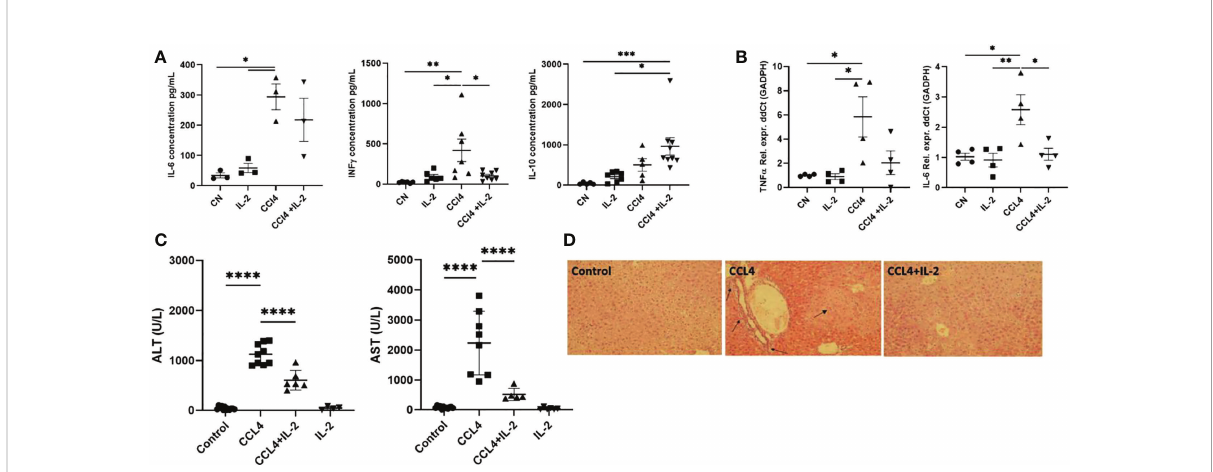
FIGURE 6 Impact of IL-2 administration on the modulation of in fl ammatory state of liver. In fl ammation of liver was quanti fi ed by performing qPCR analysis on the RNA isolated from liver biopsies, assessing the distinctive cytokine pro fi le and liver in fi ltrate in liver in fl ammation. (A) The quanti fi cation of pro and anti-in fl ammatory cytokines secreted in the serum (n=3) and (B) RNA extracted from the in fl amed liver (n=4). (C) Levels of serum ALT and AST were measured at the study endpoint at 24h post-injection (n=5). (D) H&E staining of liver sections examined via light microscopy at 20x magni fi cation. Black arrows indicate regions of excessive immune in fi ltration, and greater intensity of pink reveal regions of hepatocyte necrosis. The values are shown as the mean ± SEM and one-way ANOVA with Tukey ’ s multiple comparison test has been performed to show statistical signi fi cance *P < 0.05, **P < 0.01, ***P < 0.001 and ****P <